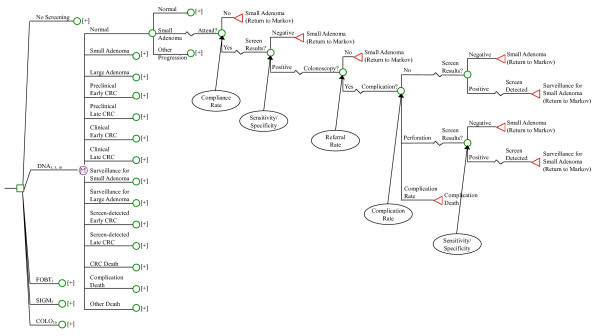
Structure of decision tree model.* * At the beginning of the first Markov cycle, all the probabilities of being in clinical early CRC, clinical late CRC, surveillance for small adenoma, surveillance for large adenoma, screen-detected early CRC, screen-detected late CRC, CRC death, complication death, and other death are zero. Ovals are the chance nodes governed by the probability related to compliance rate, sensitivity, specificity, and referral rate.: Markov cycle. Abbreviations: CRC, colorectal cancer; DNA3, stool DNA testing every 3 years; DNA5, stool DNA testing every 5 years; DNA10, stool DNA testing every 10 years; FOBT1, fecal occult blood testing every year; SIGM5, sigmoidoscopy every 5 years; COLO10, colonoscopy every 10 years; Small adenoma, adenoma smaller than 1 cm in size; large adenoma, adenoma larger than 1 cm in size; early CRC, Dukes' stage A and B colorectal cancer; late CRC, Dukes' stage C and D colorectal cancer.